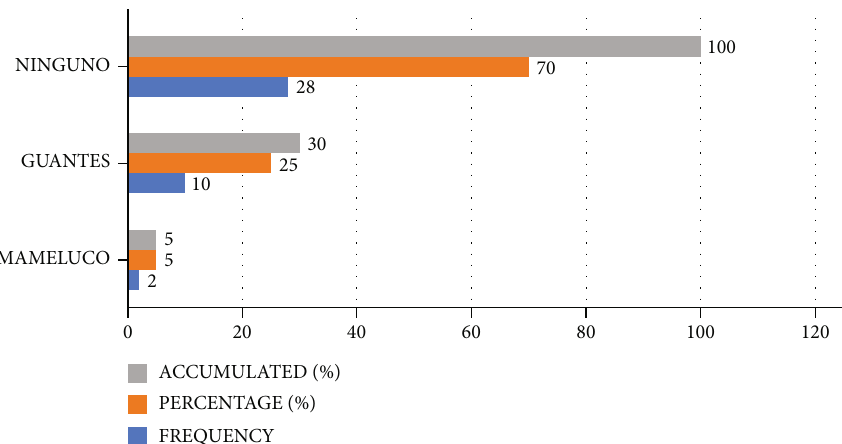
Figure 4: Results according to signs or symptoms.